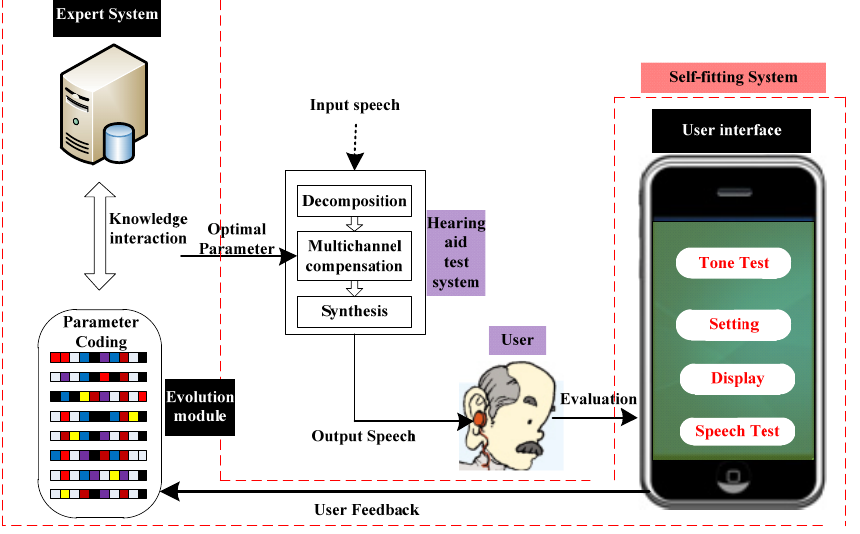
Figure 2. Overall structure diagram of self-fitting.